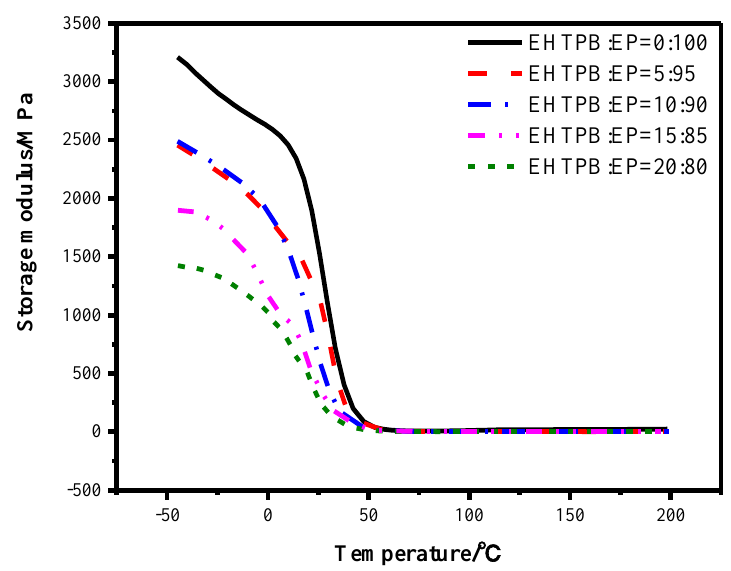
Figure 10. Storage modulus curves of the epoxy resin with different w(EHTPB)/w(EP) ratios. Materials 2018 , 11 , x FOR PEER REVIEW